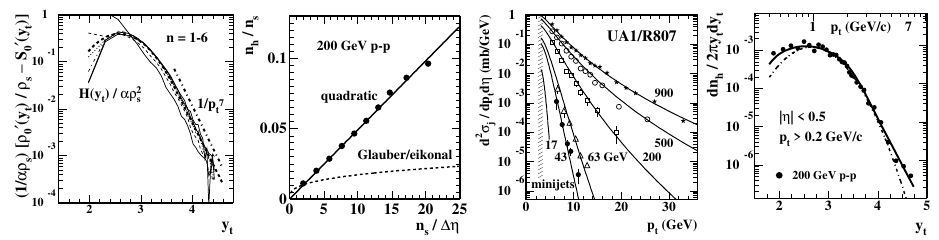
Figure 1. First: Spectrum hard components for six multiplicity classes of 200 GeV p - p collisions. Second: Relation between soft and hard charge yields. Third: Jet spectra for five p - p collision energies (points) and associated curves from Eq. (2). Fourth: Hard component for NSD p - p collisions (points) and pQCD prediction from jet measurements (solid